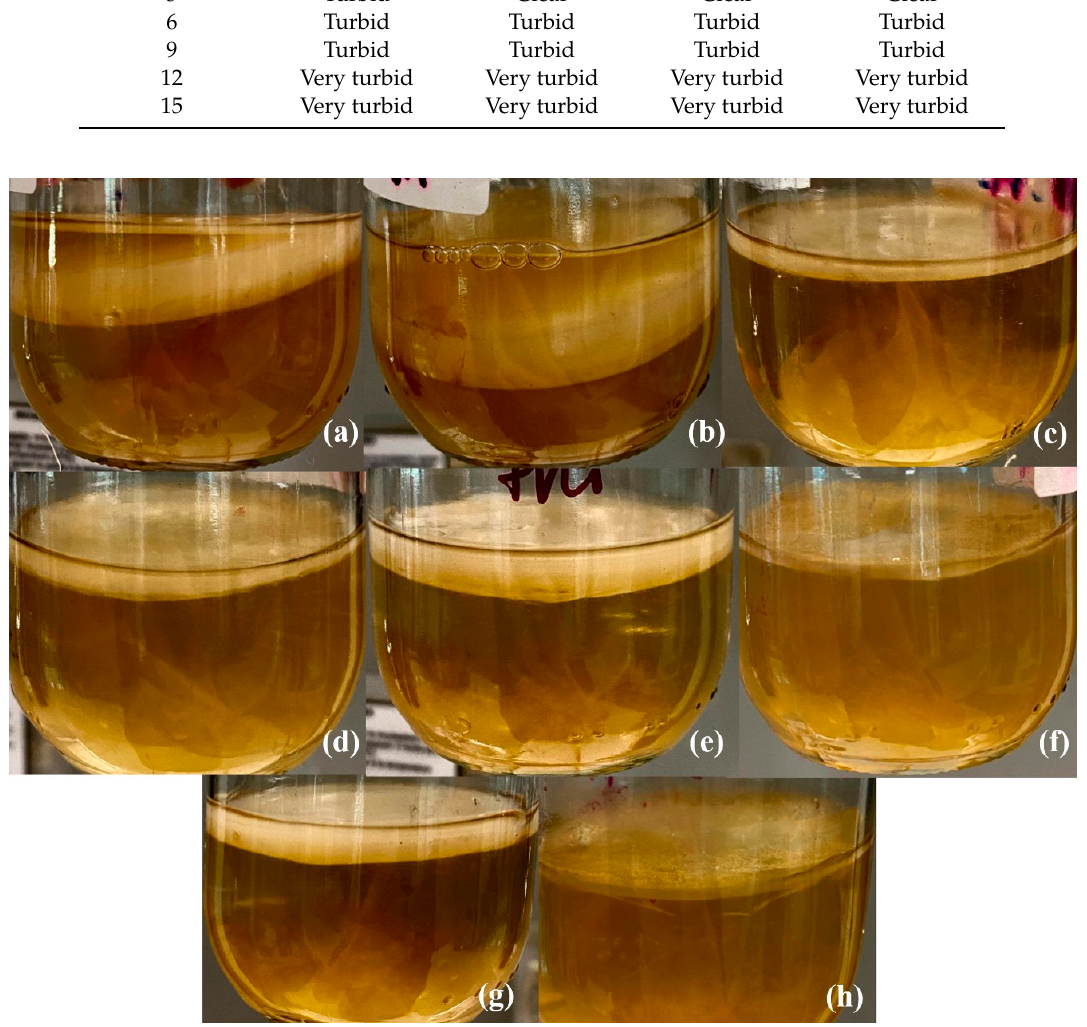
Figure 3. Representative images of the microbial cellulose films ( a ) COr + Glucose; ( b ) COr + Dextrose; ( c ) COr + Fructose; ( d ) COr + Saccharose; ( e ) CFr + Glucose; ( f ) CFr + Dextrose; ( g ) CFr + Fructose; and ( h ) CFr + Saccharose obtained after 15 days of fermentation at 25 °C.